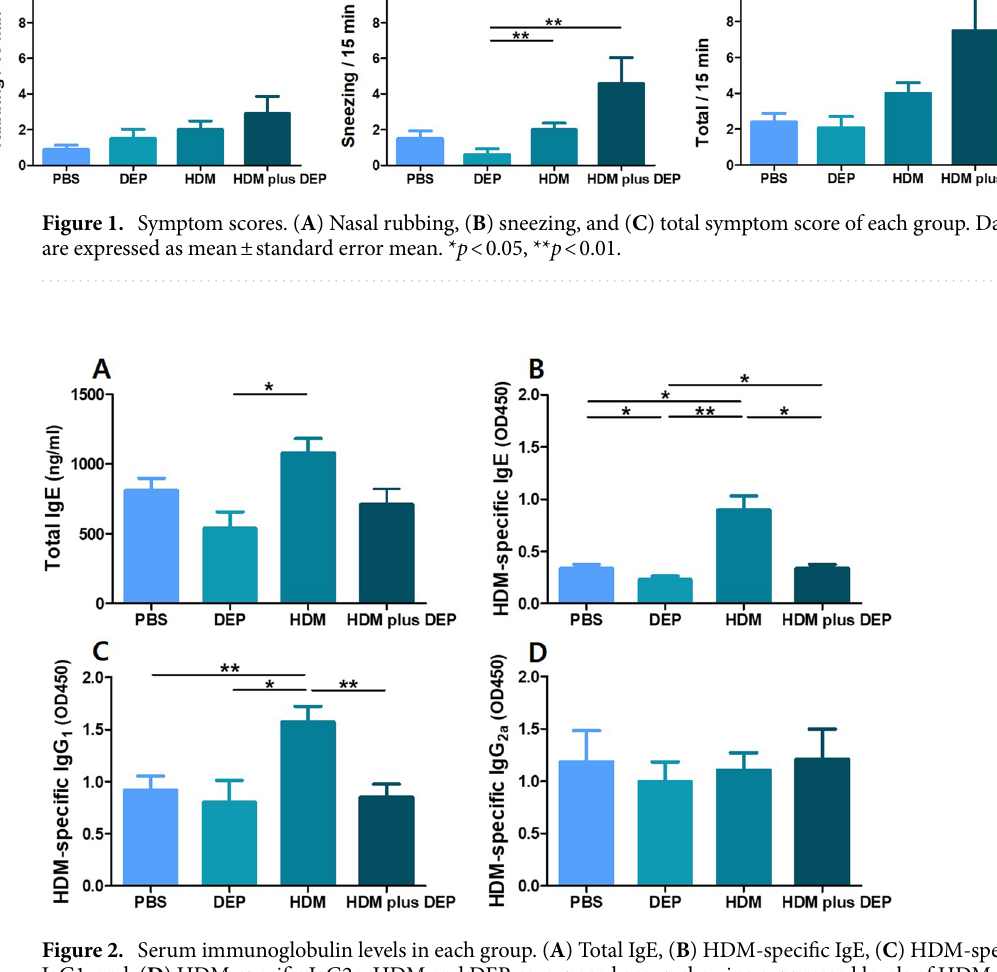
Figure 2. Serum immunoglobulin levels in each group. ( A ) Total IgE, ( B ) HDM-specific IgE, ( C ) HDM-specific IgG1, and ( D ) HDM-specific IgG2a. HDM and DEP co-exposed group showing suppressed levels of HDM- specific IgE and IgG 1 . Data are expressed as mean ± standard error mean. * p < 0.05, ** p <